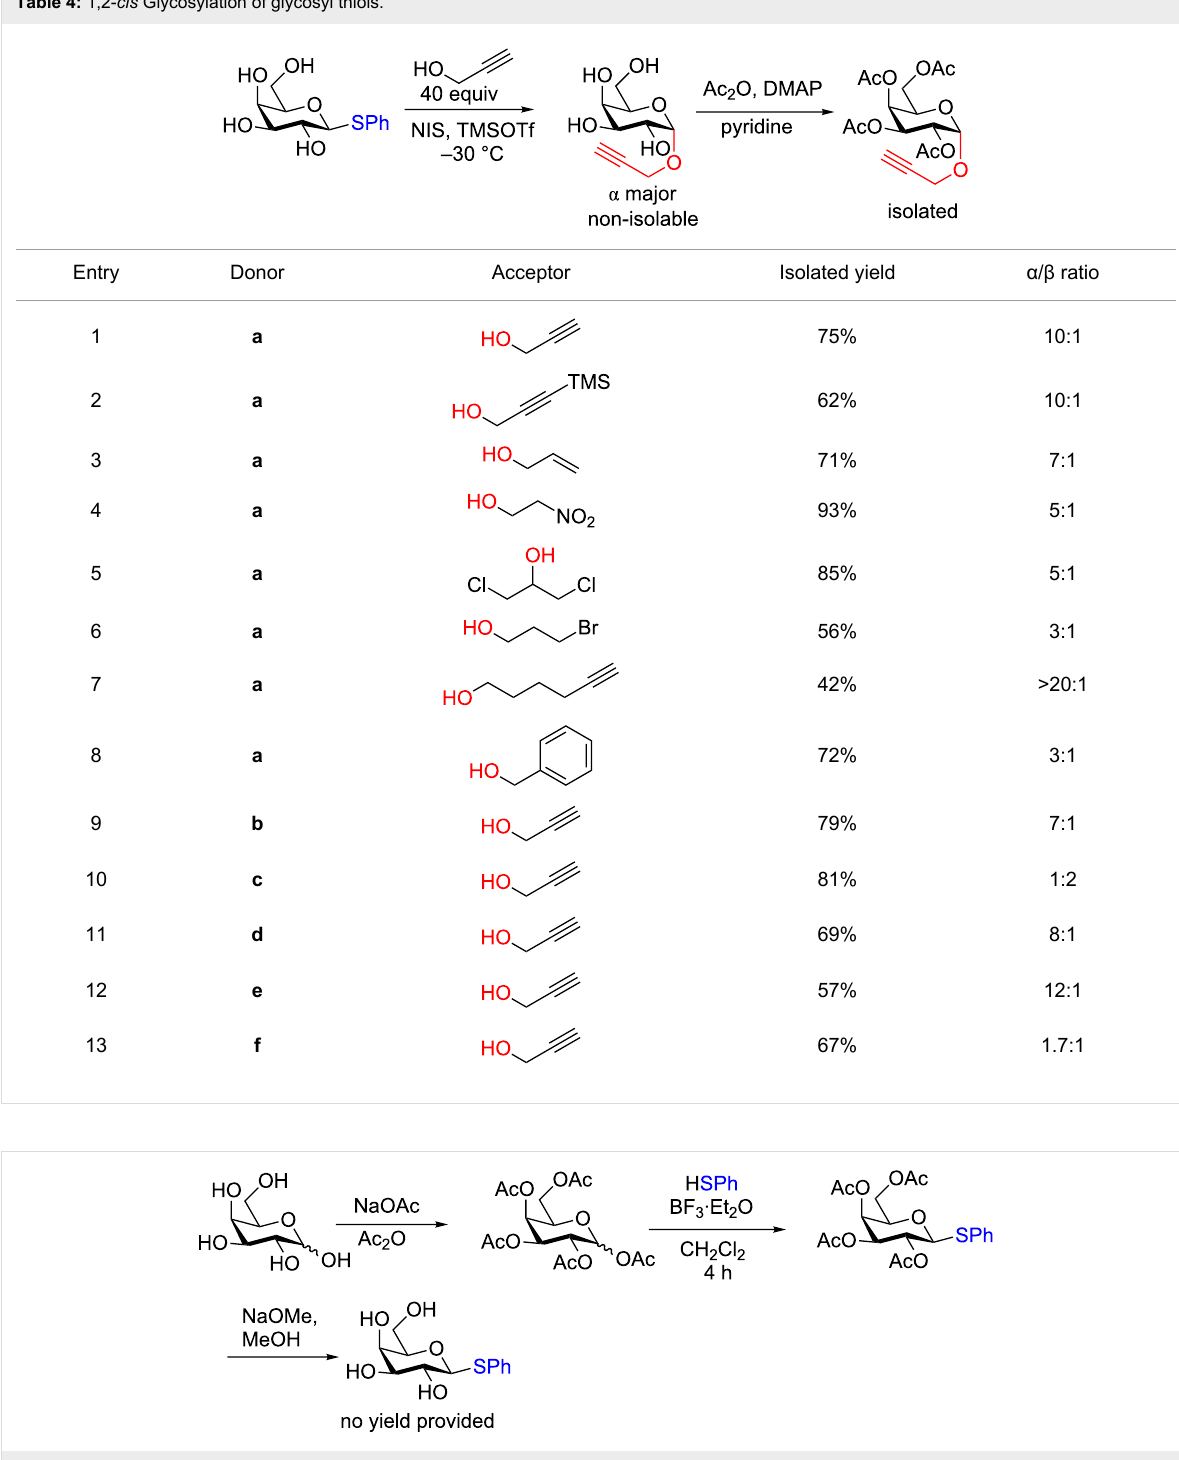
Table 4: 1,2- cis Glycosylation of glycosyl